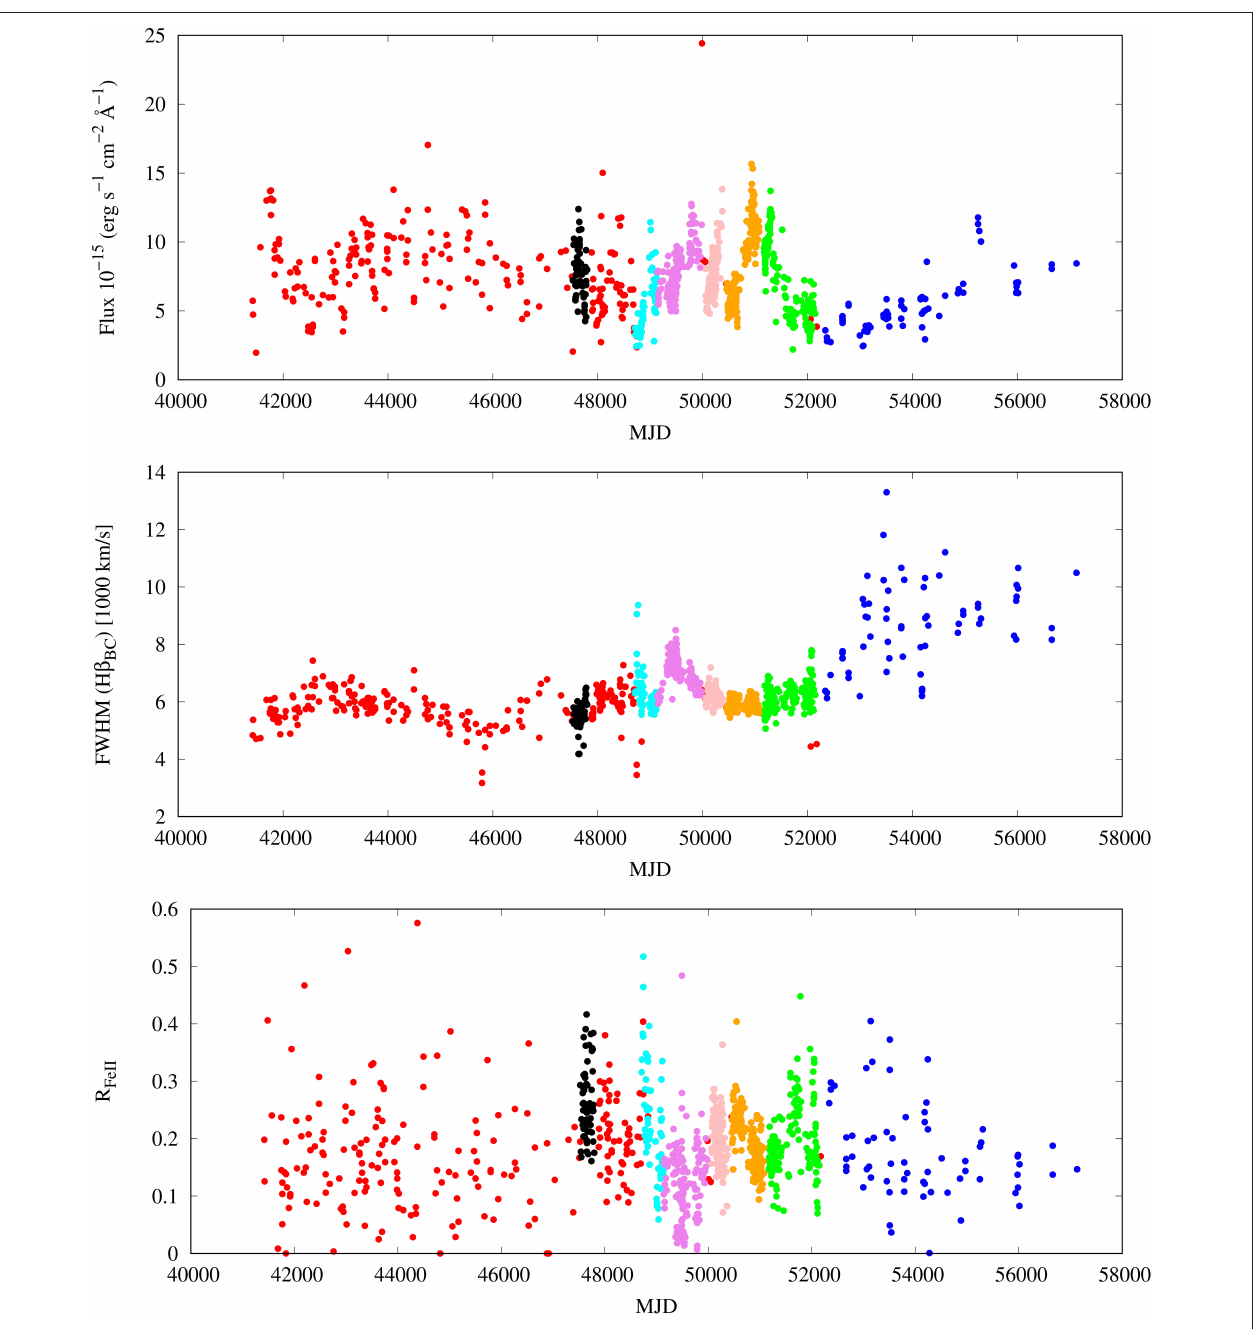
FIGURE 1 | Variability in the NGC 5548 spectra: ( top ) The light curve of the continuum measured at 5100 Å; ( middle ) FWHM H β variations; ( bottom ) R FeII change with the time. Colors correspond to different time